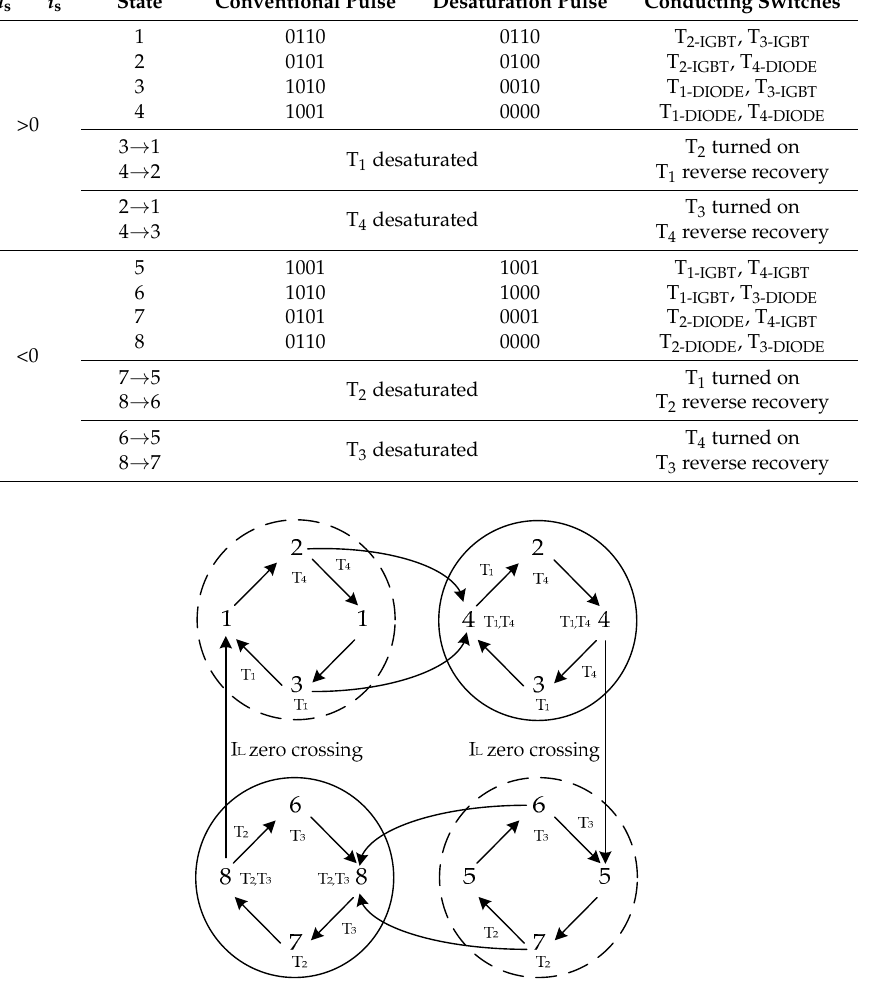
Figure 6. Process of the desaturation control of single-phase PWM converter in traction.